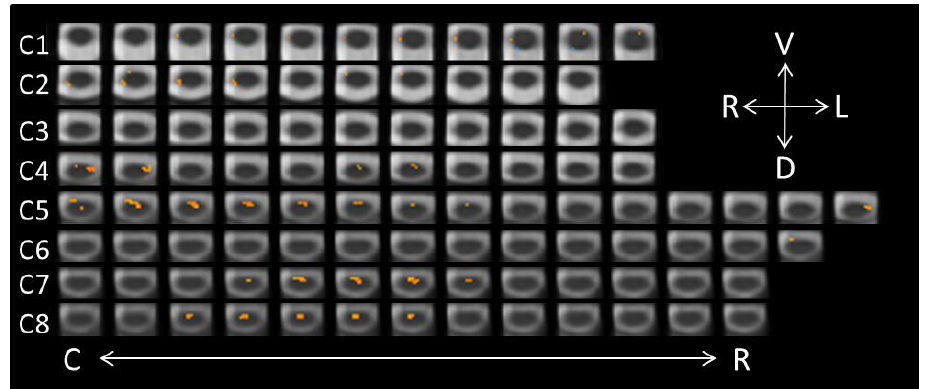
Figure 2. Axial spinal cord slices presenting the distribution of activity produced during the Neutral-Conscious/Anger-Conscious contrast ( − 1, 1). The images are oriented in radiological convention with dorsal towards the bottom of each frame, left side of the cord on the right of each frame, and are displayed caudal-to-rostral from left to right of each row ( α = 0.00556). The abbreviations related to the axial directions (top-right of the figure) are defined as follows: R = right; L = left; V = ventral; D = dorsal. The abbreviations C and R (bottom of the figure) refer to caudal and rostral, respectively. Table 2. Location of spinal cord activity in the contrasts for the conscious perception of neutral, angry, and fearful faces. Results are presented at p < 0.0056; results containing 1 or 2 voxels have been A paired contrast ( − 1, 1) was also performed on the neutral-conscious and fear-conscious runs. excluded as they are likely false positives.